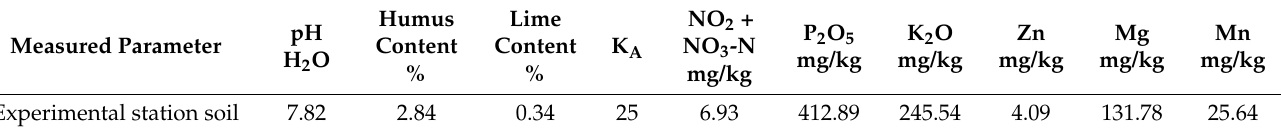
Table 2. The soil composition of the experimental